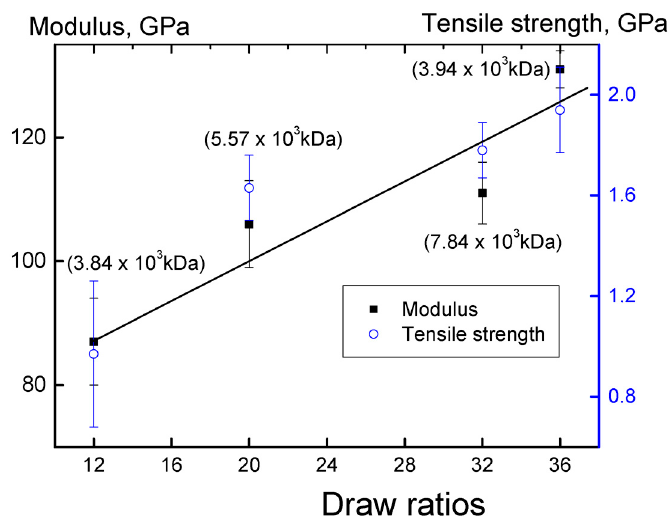
Figure 7. The dependence of the elastic modulus and tensile strength of oriented films on the drawing ratio. Reactor powders obtained from the catalytic system I at different polymerization times were used (entries 2–5). Polymer molecular weights are indicated in parentheses.